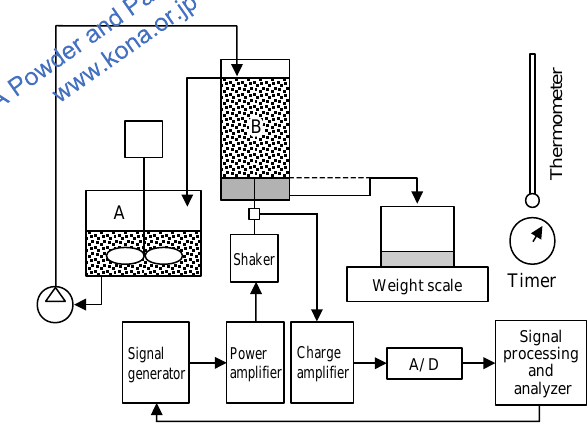
Fig. 1 Vibration filtration experimental system.